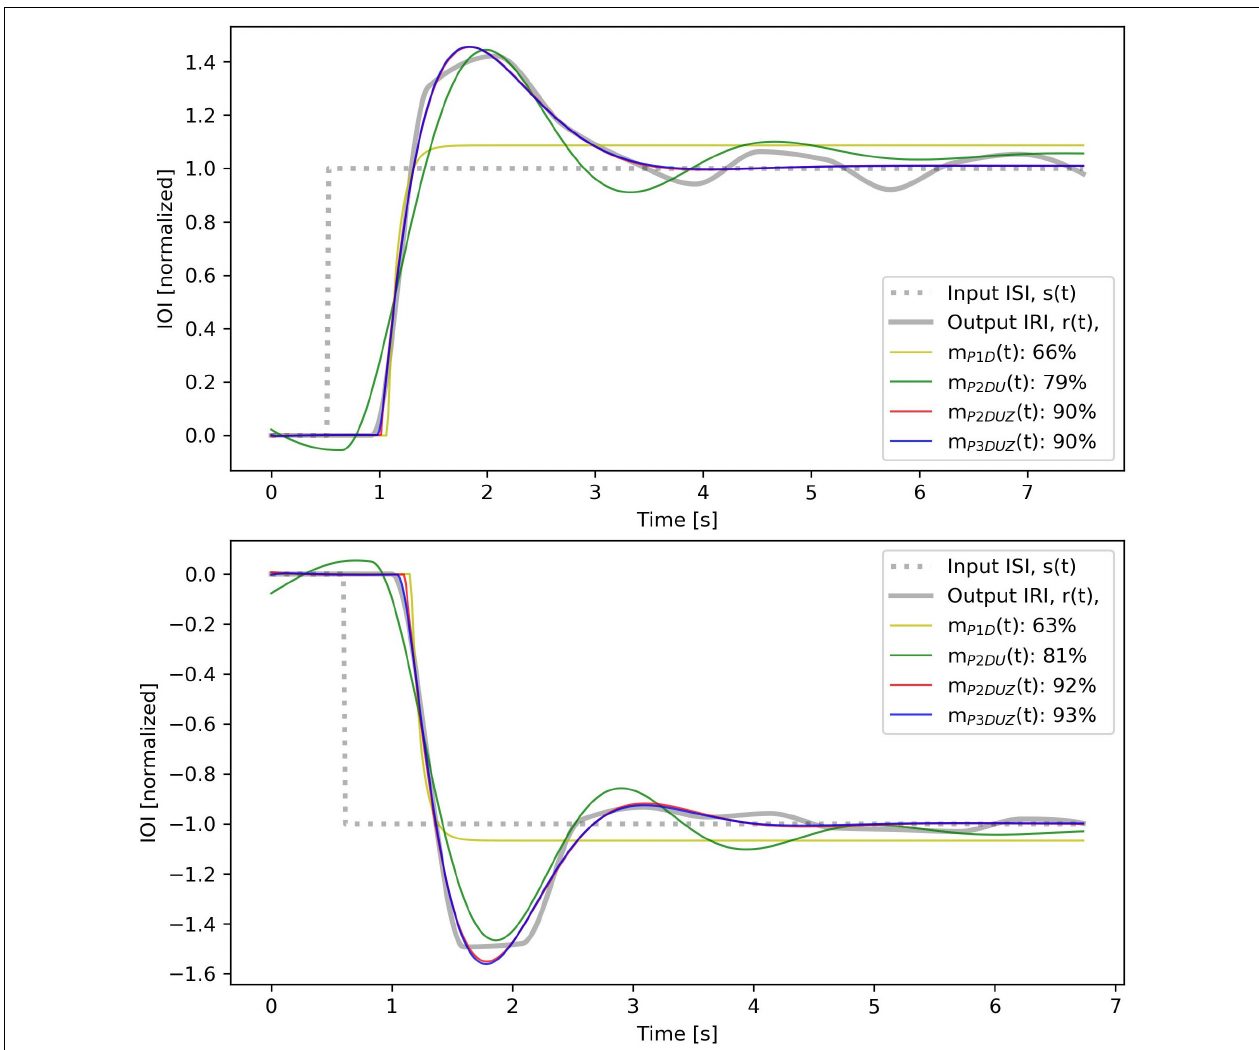
FIGURE 4 | Measured data, ISI and IRI, as well as output signals from simulations with the four models defined in section “Data Analysis.” The input s ( t ) and the output r ( t ) amplitudes are normalized. In addition, a processing delay of 0.4 s has been added to the output signal, before the model fitting.